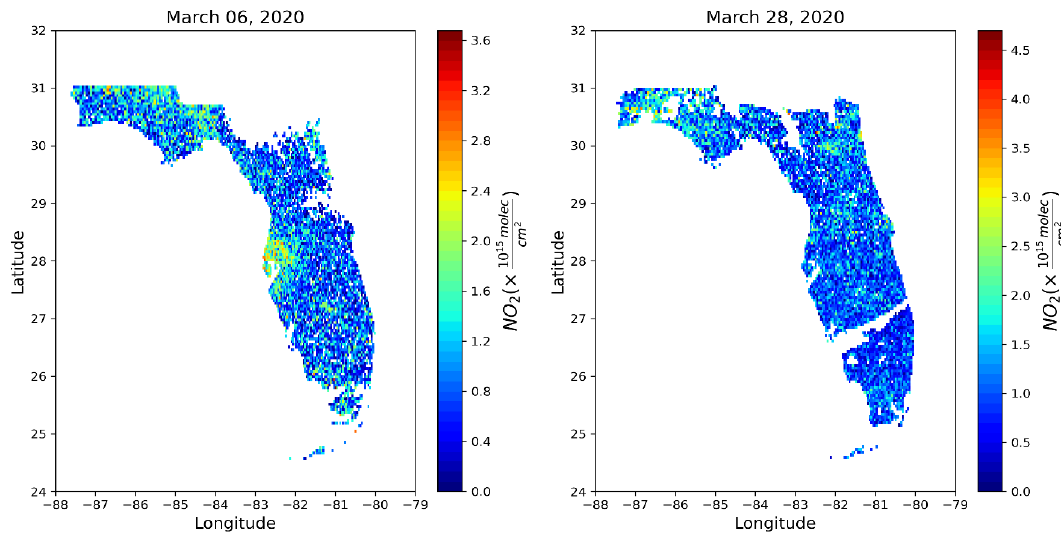
Figure 3. Examples of Sentinel-5P daily measurement for NO 2 densities over Florida.